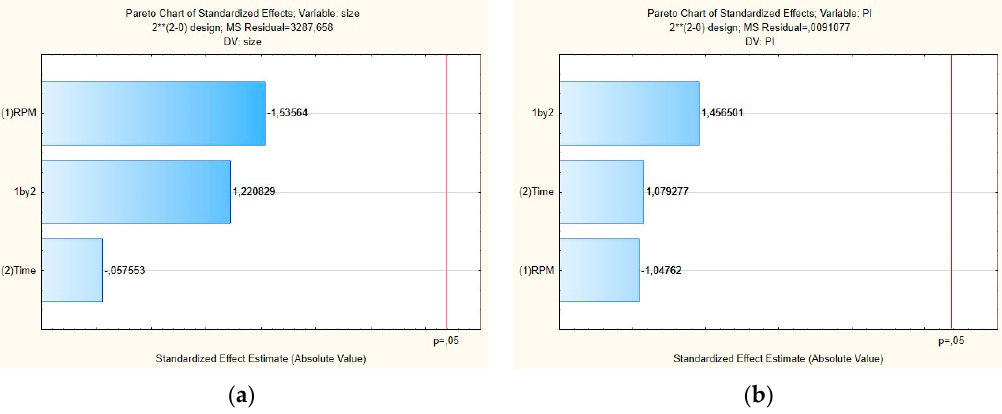
Figure 2. Pareto charts of the standardized effects for the placebo obtained for ( a ) particle size (Z-average) and ( b ) polydispersity index (PDI).